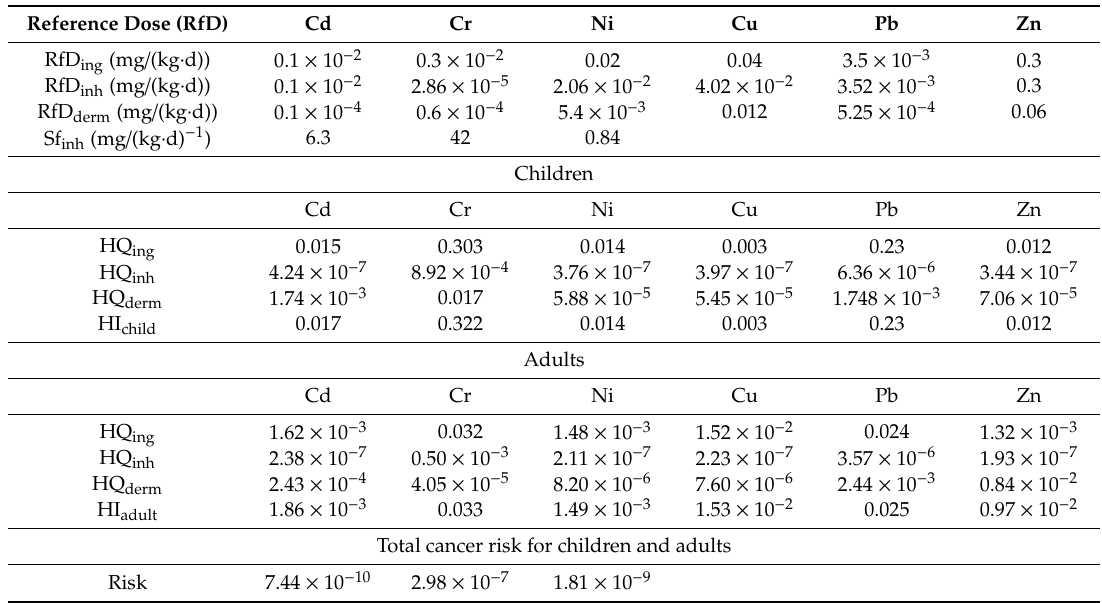
Table 4. Noncarcinogenic risk index and carcinogenic risk of heavy metals (children and adults) in atmospheric